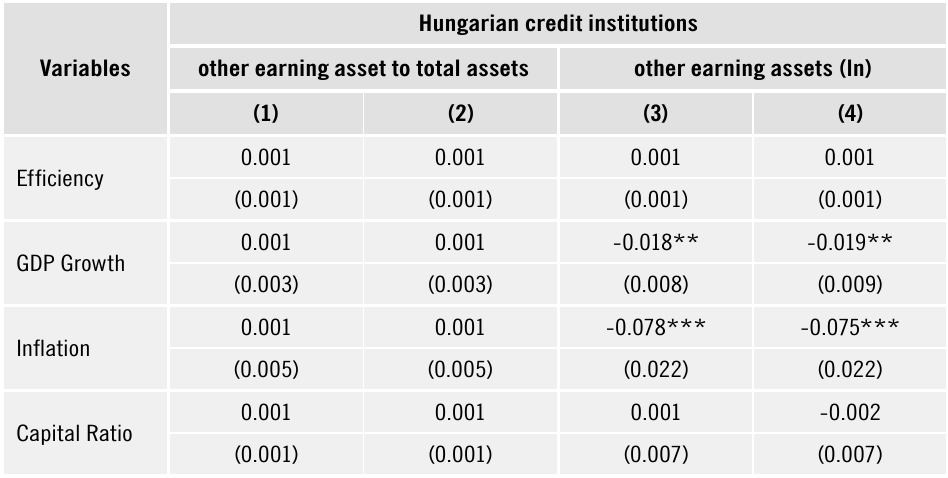
Table 11. Data presenting estimates based on GLS regressions with a random effect on Hungarian credit institutions in 2008-2015. Data have been sourced from unconsolidated financial statements. Institution-specific characteristics appear as one-year lagged variables in all specifications. The bank levy (BL) is represented by a dummy variable indicating 1 for all years the levy applies to, and zero for all remaining years. Robust standard errors that control for clustering at the bank level are reported in